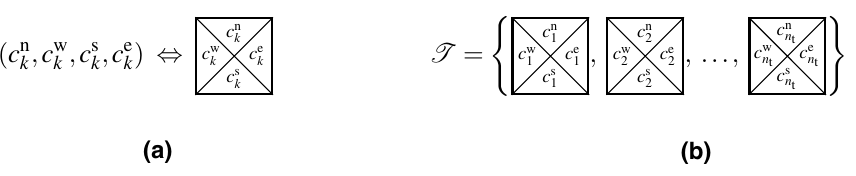
Figure 2. Graphical representation of ( a ) a Wang tile k , and of ( b ) a tile set T .